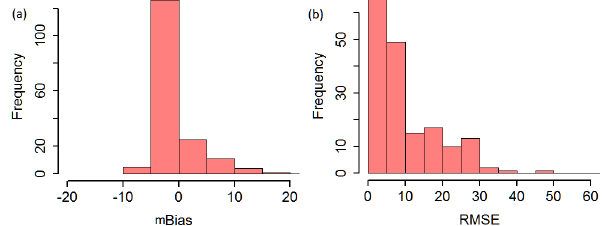
Figure 9. The distribution of mBias (a) and RMSE (b) derived from the scene-by-scene comparison between the AVHRR GAC raw snow datasets and the MODIS snow products over the region P140-R40/41 throughout the snow season between 2012 and